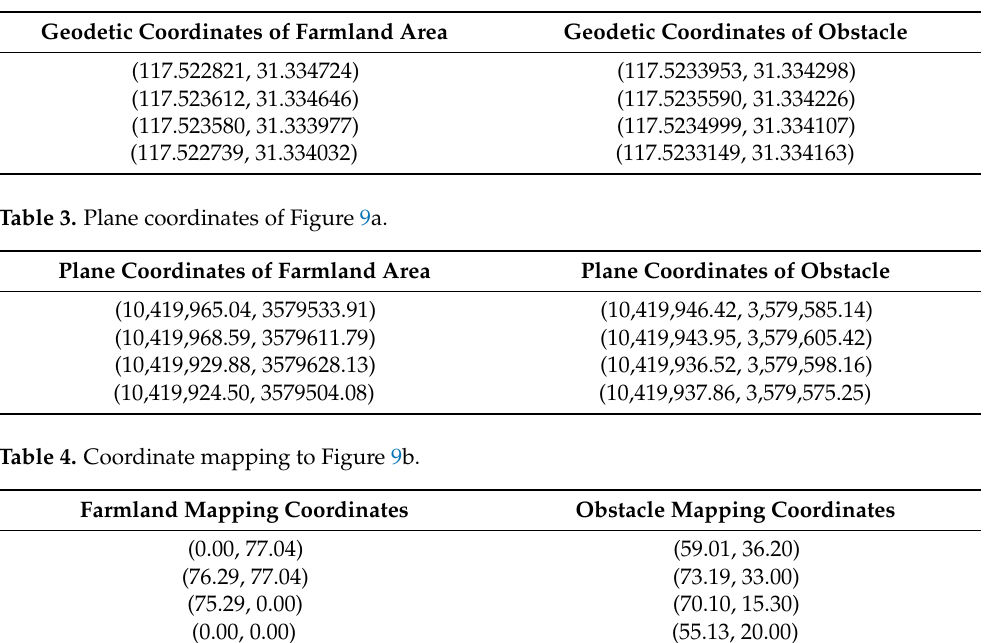
Table 2. Geodetic coordinates of Figure 9a.